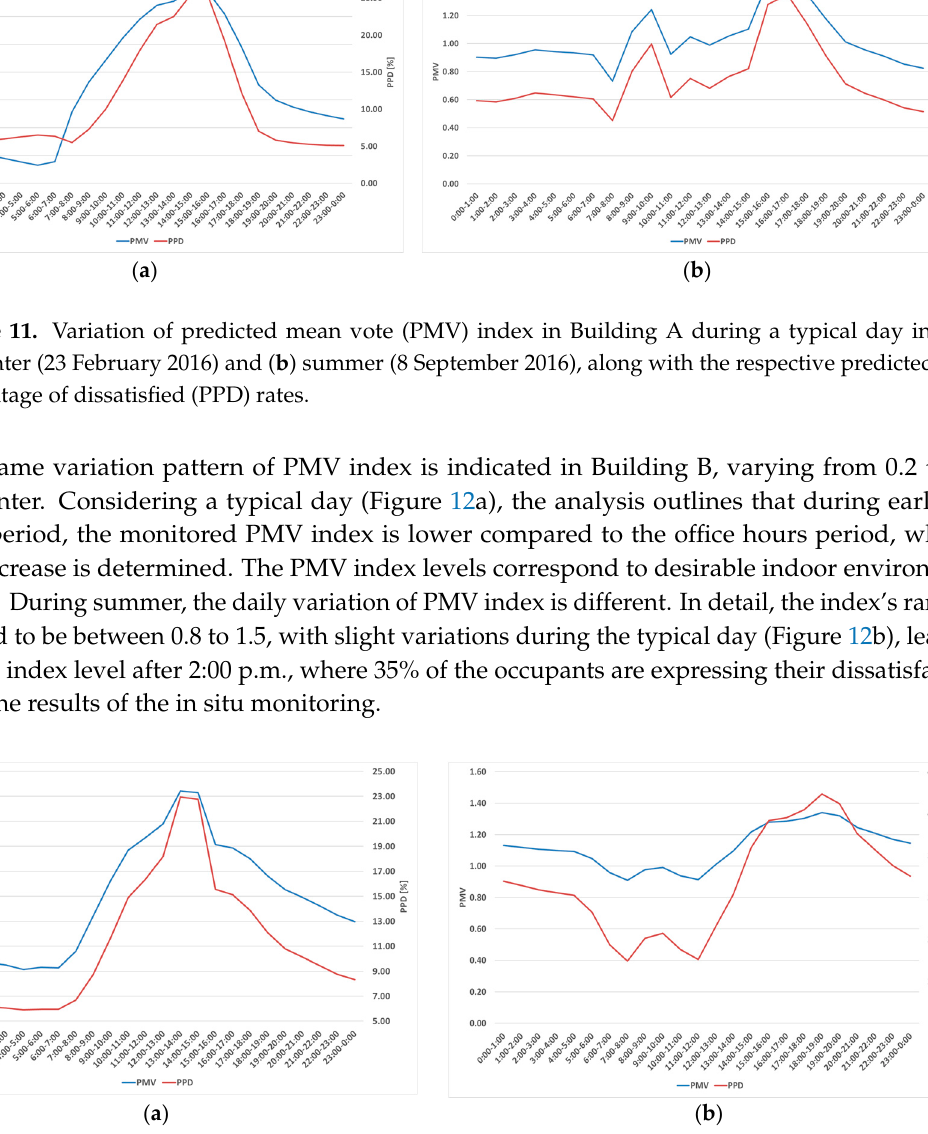
( b ) Figure 13. Variation of PMV index in Building C, during a typical day in: ( a ) winter (10 March 2016) and ( b ) summer (14 September 2016) along with the respective PPD rates. An analytical presentation of the collected data for all cases is given in Tables 4 and 5, both for winter and summer periods.